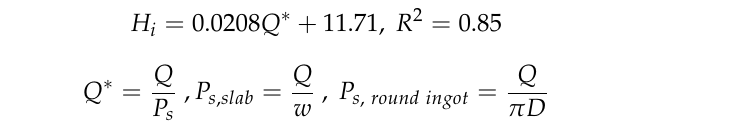
Figure 8. Schematic illustration of rewetting test for impingement zone height measuring.